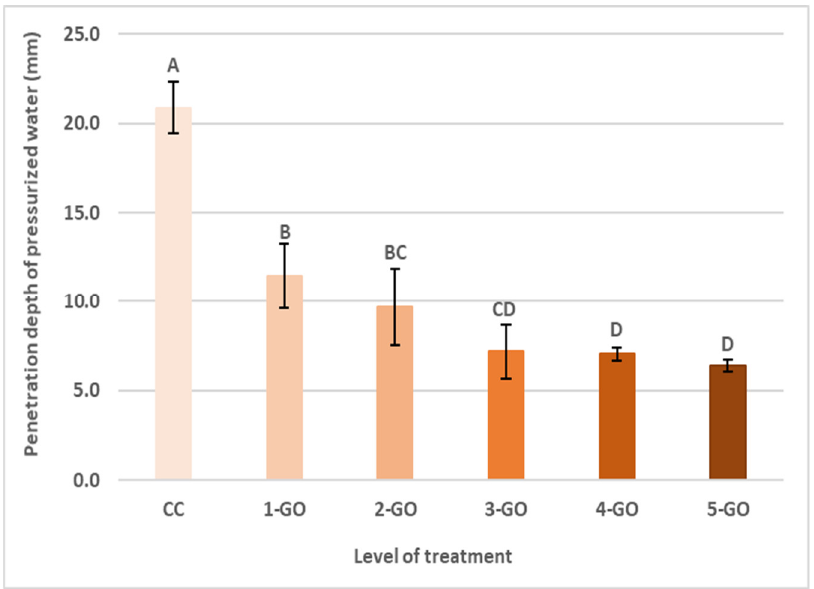
Figure 2 . Depth of water penetration under pressure at different treatment levels. Capital letters indicate minimum significant differences between treatment levels. Vertical bars represent the mean and the standard error (SE). Statistical differences are indicated by different letters (LSD test, p < 0.05).